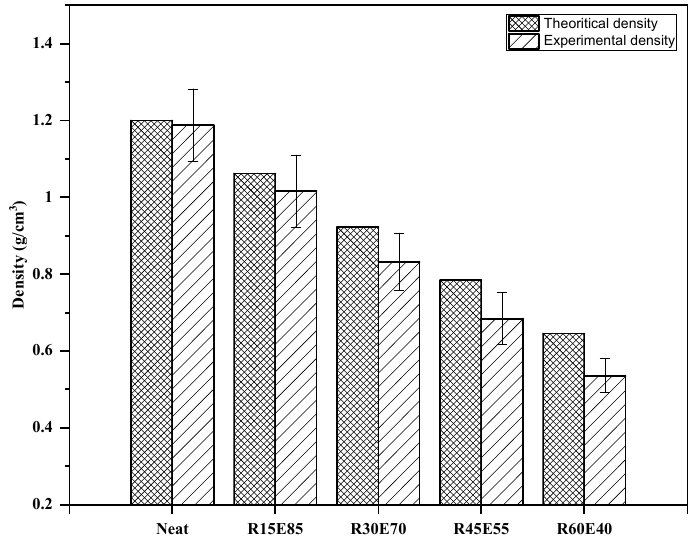
Figure 5. Density of composites.